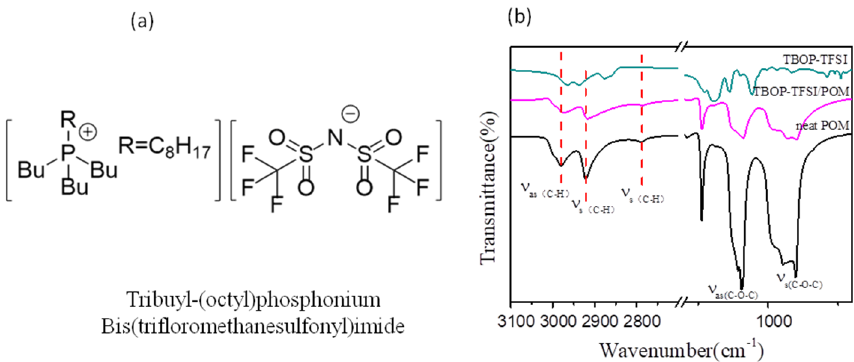
Figure 2. ( a ) Molecular structure of TBOP-TFSI; ( b ) Fourier transfrom infrared (FTIR) spectra of POM with TBOP-TFSI.